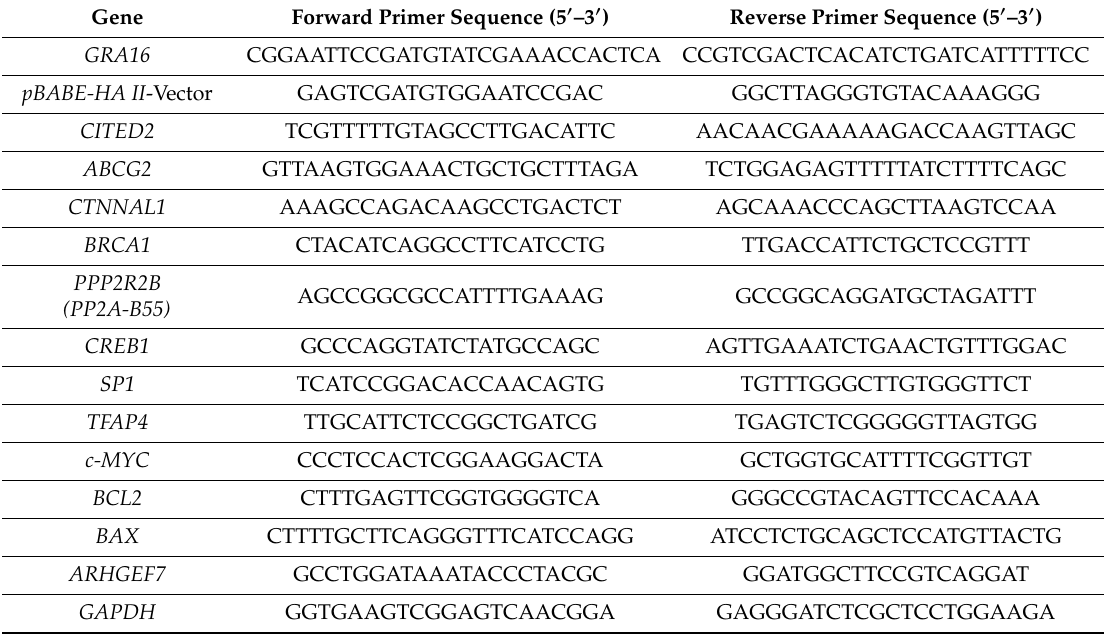
Table 1. Primer Sequence Used in Conventional PCR and